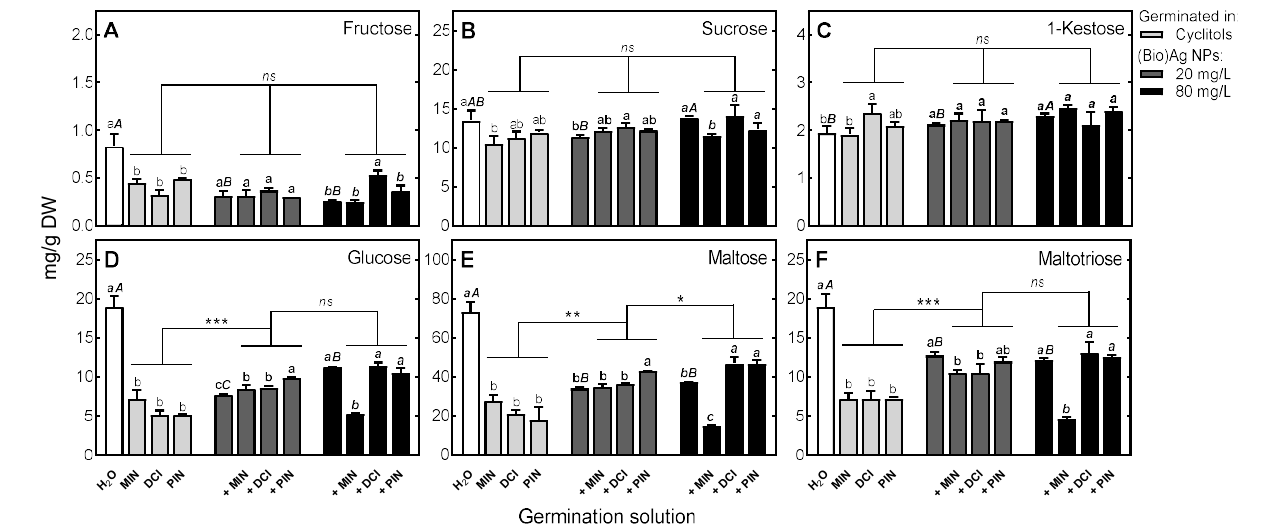
Figure 6. The effect of (Bio)Ag NPs (at 20 and 80 mg/L) and their mixtures with 100 mM myo -inositol (MIN), D - chiro -inositol (DCI) and D -pinitol (PIN) on the concentrations of soluble carbohydrates in endosperms of 3-day-old wheat ( Triticum aestivum L. cv. Ostka Strzelecka) seedlings: ( A ) Fructose , ( B ) Sucrose , ( C ) 1-Kestose , ( D ) Glucose , ( E ) Maltose , ( F ) Maltotriose . Values are means ( n = 3) + SD. Bars with the same le(cid:308)ers (a) were not significantly ( p < 0.05) different after ANOVA test and Tukey’s post hoc corrections, whereas one to three asterisks (*, **, ***) denote significant differences (at p < 0.05, 0.01 and 0.001) between effects of cyclitols alone and in mixtures with (Bio)Ag NPs. This effect was not related to the concentration of (Bio)Ag NPs applied or to the pres- ence of DCI or PIN. In contrast, the addition of MIN to (Bio)Ag NPs (at a concentration of 80 mg/L) reduced the concentrations of sucrose, glucose, maltose and maltotriose (Figure 6B,D – F).